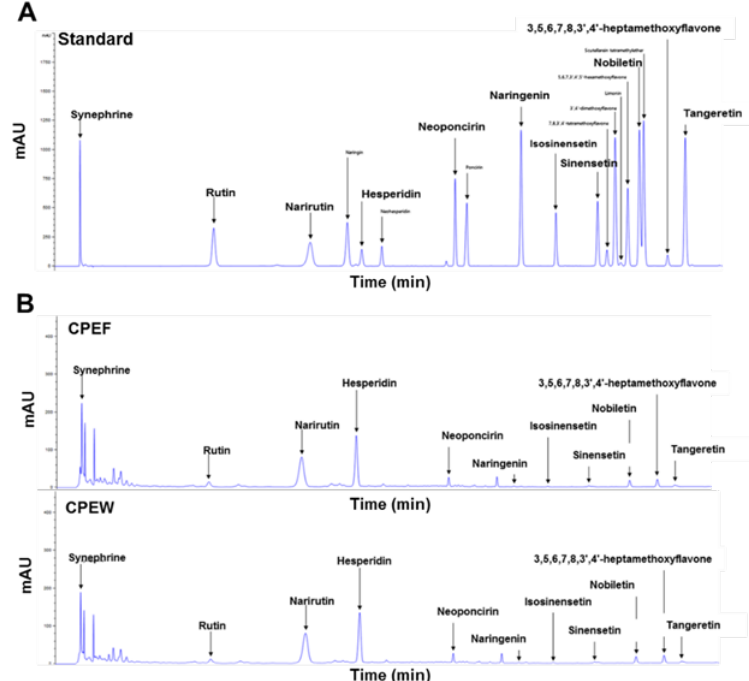
Figure 1. Characteristic analysis of bioactive components in citrus peel extracts by high-performance liquid chromatography at 210 nm. ( A ) Chromatogram showing main components of citrus peel extracts analyzed by standard solution ( B ) Freeze-drying (CPEF) of citrus peel water extracts; hot-air-drying (CPEW) of citrus peel water extracts.